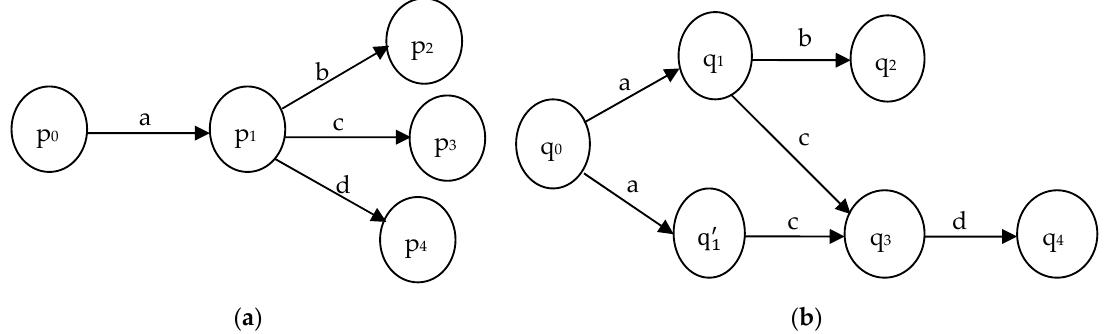
Figure 3. ( a ) State transition diagram of Equation (6); ( b ) State transition diagram of Equation (9).